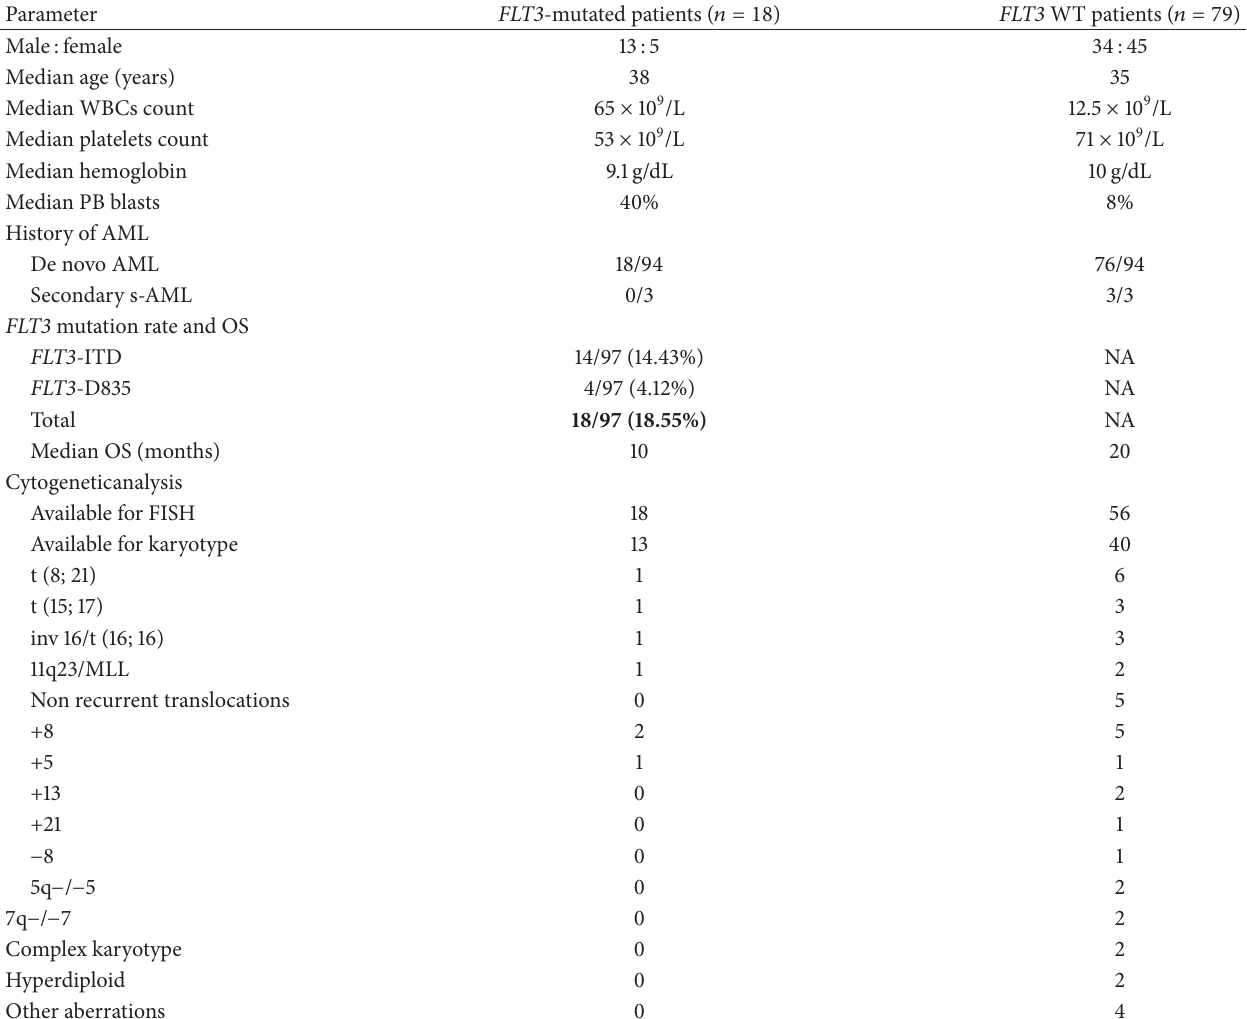
Table 1: Summary of the characteristics of the patients included in the